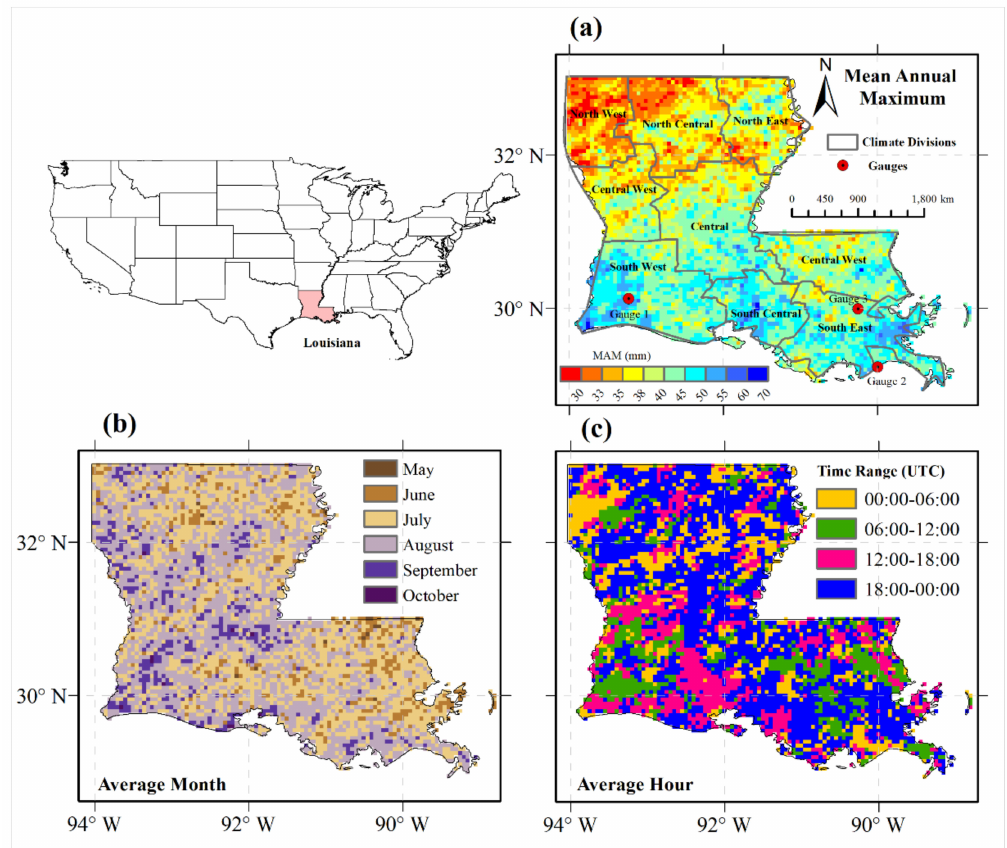
Figure 1. ( a ) Spatial distribution of the hourly Mean Annual Maxima (MAM; in mm). ( b ) The average month of AMS occurrence in each pixel. ( c ) The average 6-h of AMS occurrence in each pixel. Results are based on the period of study